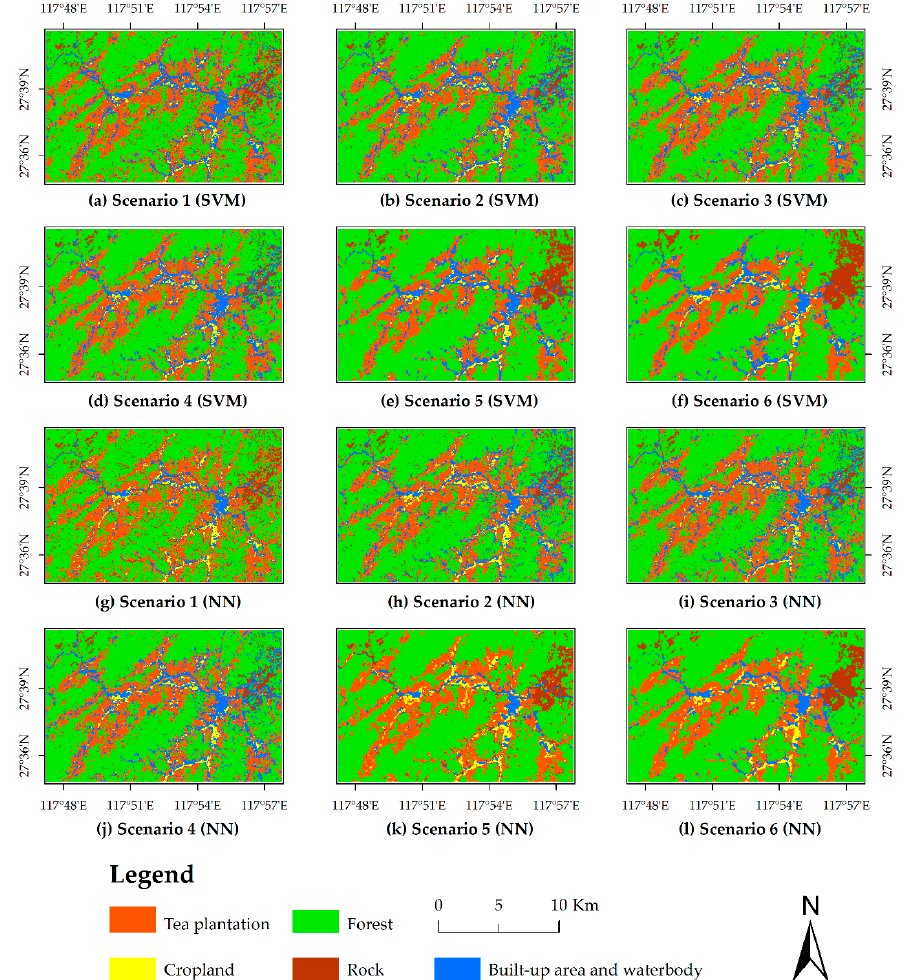
Figure 6. Classifications of different scenarios using the support vector machine (SVM) and neural network (NN) algorithms: ( a ) scenario 1 by SVM algorithms, ( b ) scenario 2 by SVM algorithms, ( c ) scenario 3 by SVM algorithms, ( d ) scenario 4 by SVM algorithms, ( e ) scenario 5 by SVM algorithms,